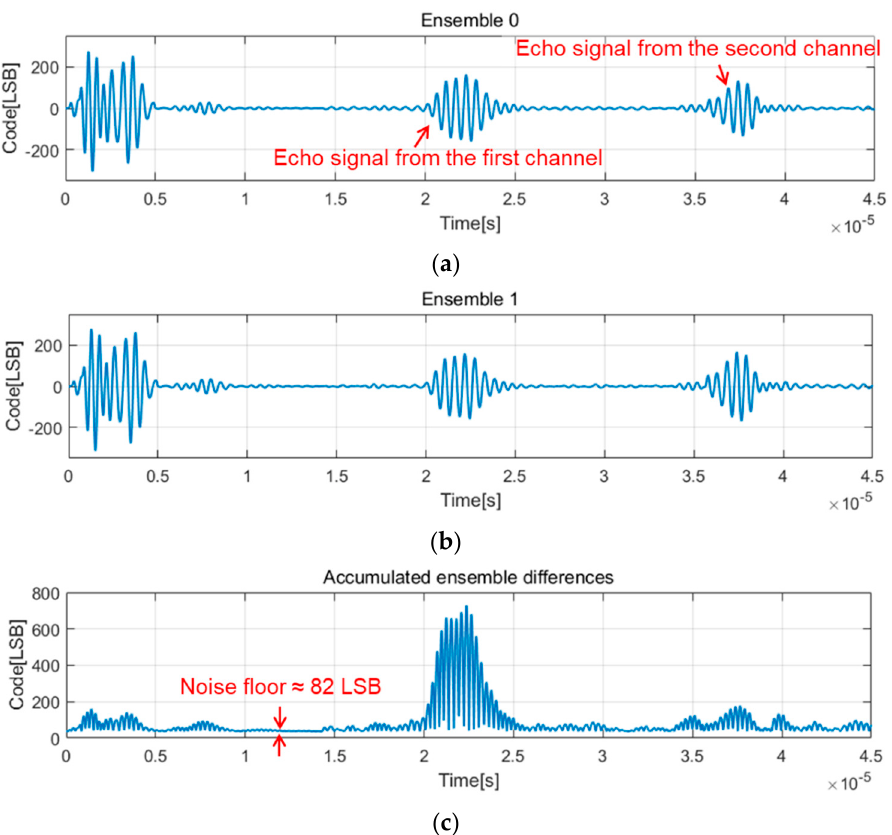
Figure 17. Measured digital waveforms using flow phantom model: ( a ) ensemble signal with index 0, ( b ) ensemble signal with index 1, and ( c ) accumulated ensemble differences, ∑ |E N —E N − 1 |.